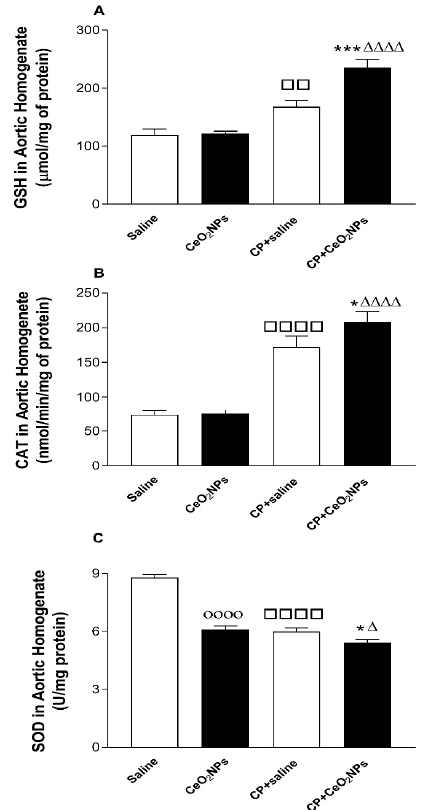
Figure 1. Glutathione (GSH, ( A )) concentration in aortic homogenates of rats intratracheally instilled with either saline ( n = 8) or CeO 2 NPs ( n = 8) with ( n = 8) or without ( n = 8) CP administration. *** P < 0.001 compared with CP + saline-treated group. ∆∆∆∆ P < 0.0001 compared with CeO 2 NPs-treated group. (cid:3)(cid:3) P < 0.01 compared with saline-treated group. Catalase (CAT, ( B )) activity in aortic homogenates of rats intratracheally instilled with either saline ( n = 8) or CeO 2 NPs ( n = 8) with ( n = 6) or without ( n = 6) CP administration. * P < 0.05 compared with CP + saline-treated group. ∆∆∆∆ P < 0.0001 compared with CeO 2 NPs-treated group. (cid:3)(cid:3)(cid:3)(cid:3) P < 0.0001 compared with the saline-treated group. Superoxide dismutase (SOD, ( C )) activity in aortic homogenates of rats intratracheally instilled with either saline ( n = 8) or CeO 2 NPs ( n = 8) with ( n = 8) or without ( n = 8) CP administration. * P < 0.05 compared with the CP + saline-treated group. ∆ P < 0.05 compared with the CeO 2 NPs-treated group. (cid:3)(cid:3)(cid:3)(cid:3) P < 0.0001 compared with the saline-treated group. oooo P < 0.0001 compared with the saline-treated group. Data are mean ±